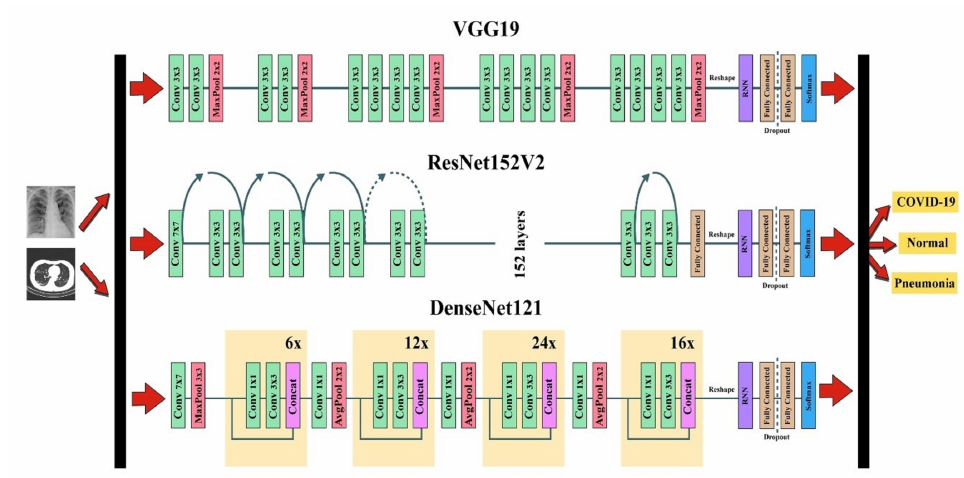
Figure 4. The combined CNN–RNN network